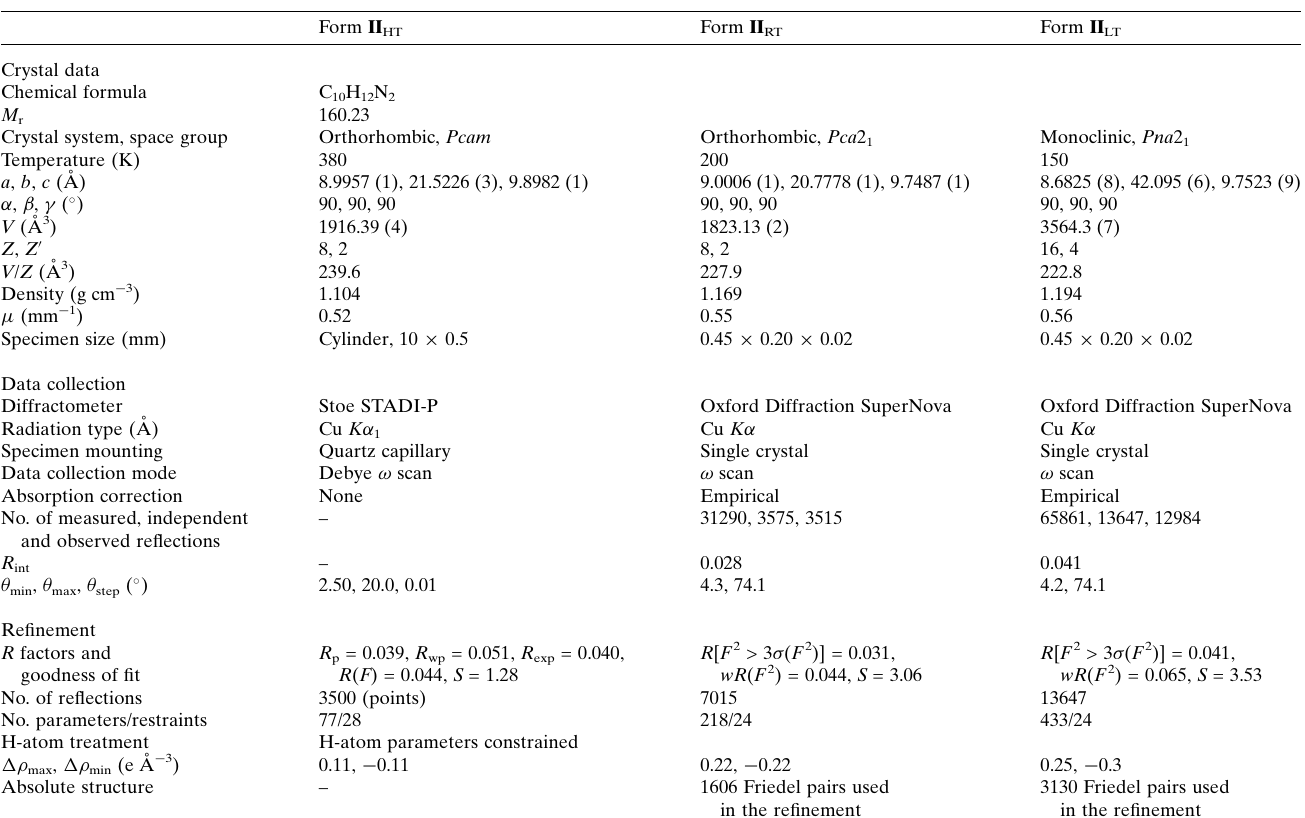
Table 1 Summary of crystal data, X-ray diffraction data and structure refinement.